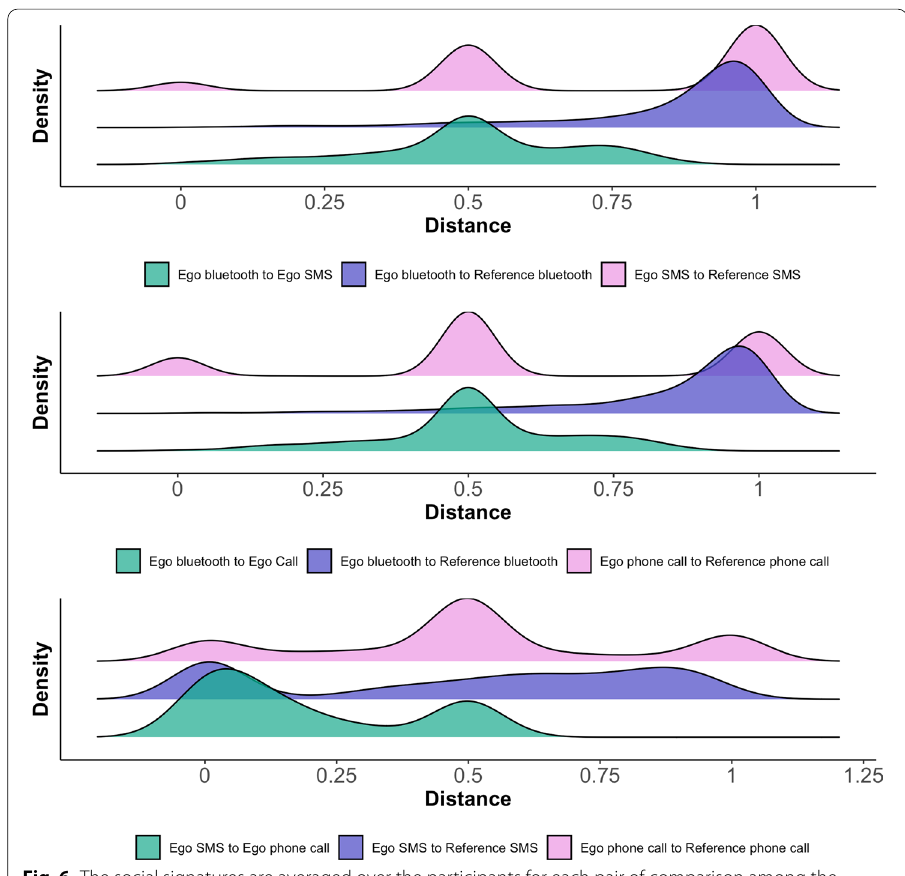
Fig. 6 The social signatures are averaged over the participants for each pair of comparison among the three networks. The similarities of social signatures within a given individual is indicated by the lower JSD of ego-to-ego network comparisons. The top panel compares the ego bluetooth to ego SMS distances (green) to reference distances for the ego’s bluetooth and a reference social network member’s bluetooth signatures (purple) and the ego’s SMS and a reference social network member’s SMS (pink). The middle panel compares the ego SMS to ego phone call distances (green) to reference distances for the ego’s bluetooth and a reference social network member’s bluetooth signatures (purple) and for the ego’s phone call and a reference social network member’s phone call signatures (pink). The bottom panel compares the ego SMS to ego phone call distances (green) to reference distances for the ego’s SMS and a reference social network member’s SMS signatures (purple) and the ego’s phone call and a reference social network member’s phone call